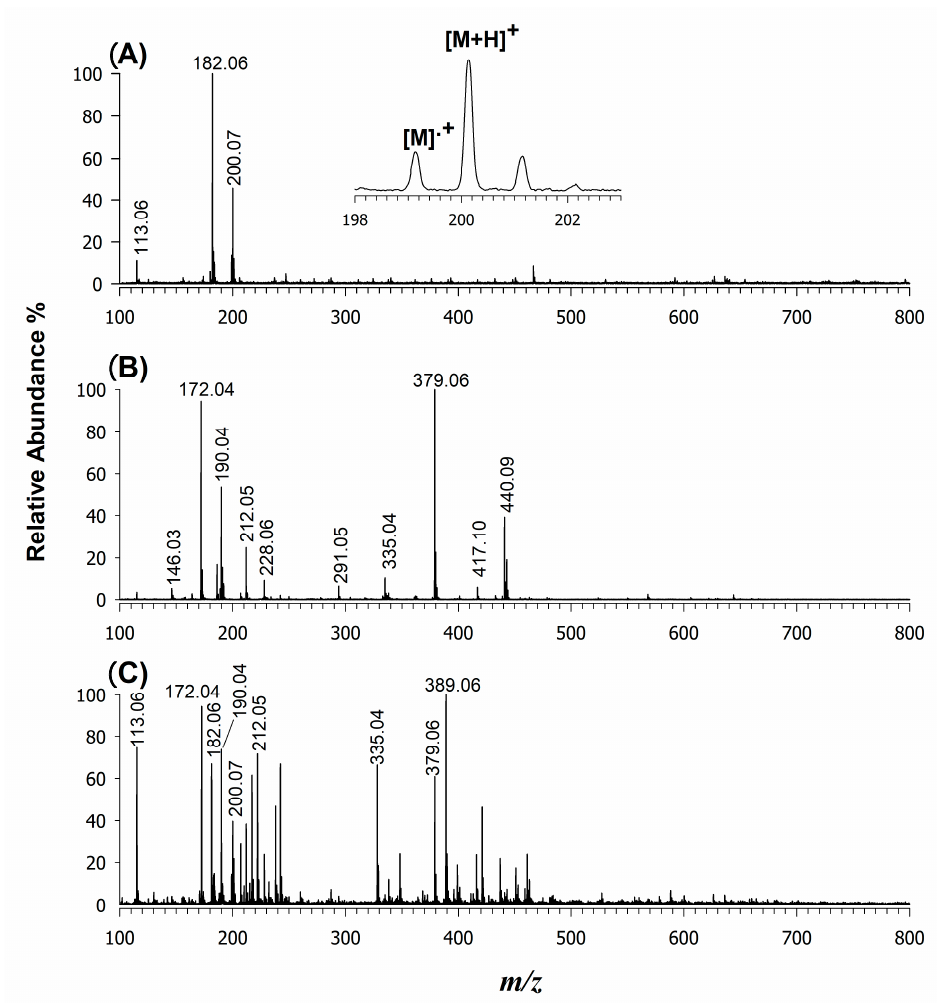
Figure 2. Positive LDI-MS spectra of matrices: ( A ) CPPA with a fluence of 3 mJ / cm 2 , ( B ) CHCA at 10 mJ / cm 2 and ( C ) an equimolar mixture of CPPA and CHCA (5 mJ / cm 2 ). LDI-MS: laser desorption / ionization mass spectrometry.